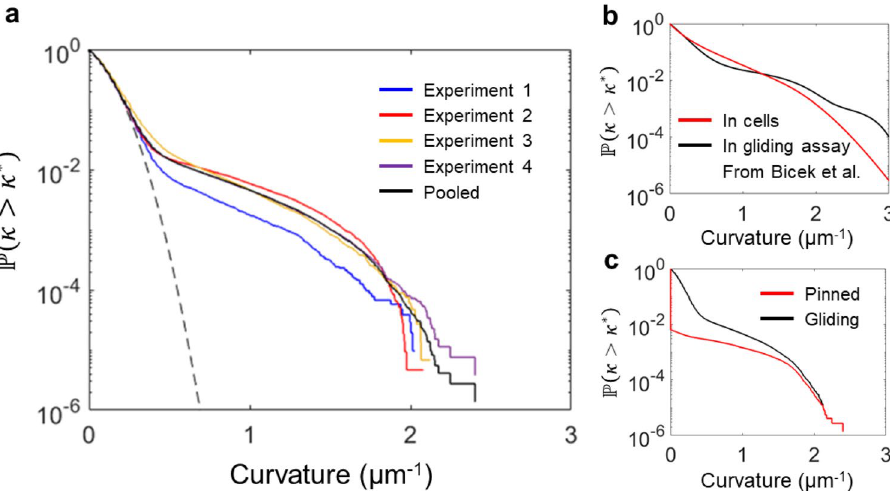
Figure 3. Curvatures of all microtubule segments. ( a ) The complement of the cumulative distribution function of the curvatures of 0.5 μm microtubule segments for repeated experiments with 1 mM ATP, 500 μm −2 kinesin (Experiment 1: N = 107,107–blue; Experiment 2: N = 219,733–yellow; Experiment 3: N = 151,324–red, Experiment 4: N = 269,897–purple). The black solid line is the cumulative distribution of pooled data from the four individual experiments. The dashed black line indicates the expected curvature distribution for a persistent random walk with a 100 μm persistence length. ( b ) Curvature distributions found by Bicek et al. 33 in motility assays (black) and living cells (red). ( c ) The segments of the pinned microtubules (red line) represent a fraction of all segments (black line, same as in a ) which increases with curvature. The curvature distribution of only pinned microtubule segments is zero-padded to match the population size of all microtubule